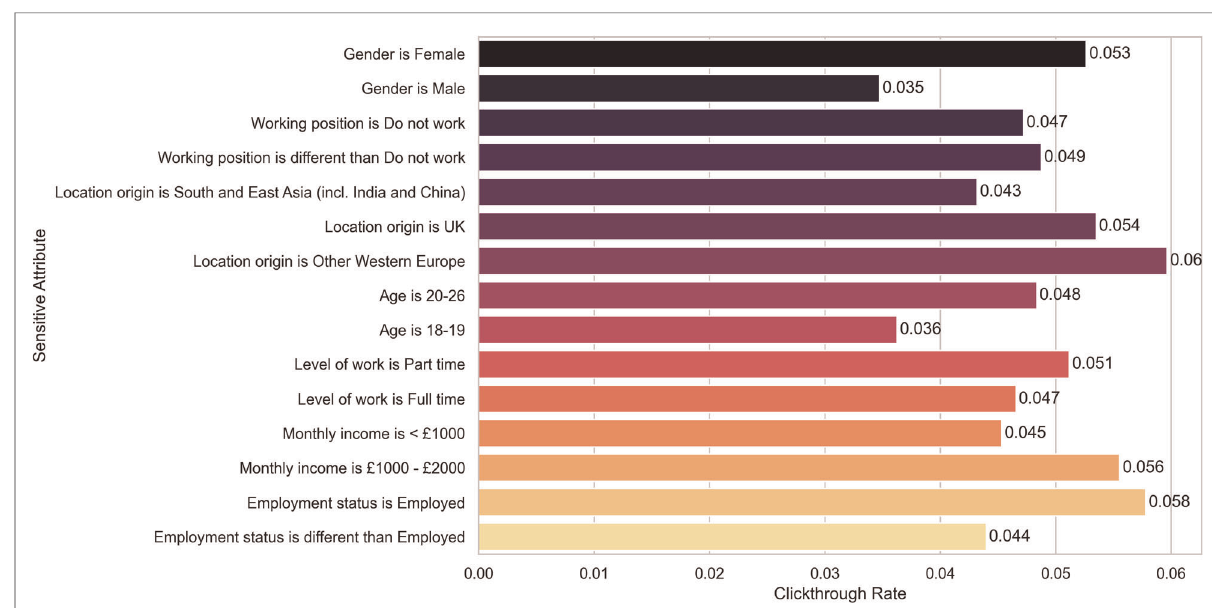
FIGURE 2 Percentage of WHO-5 step-ups for each sensitive attribute. None of the differences remain statistically signi fi cant after correcting for multiple hypotheses